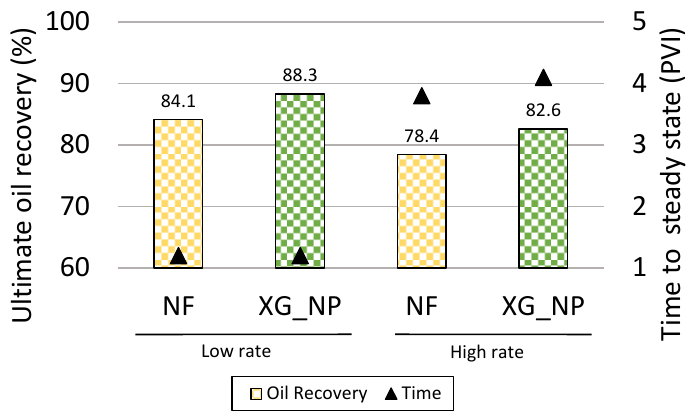
Figure 10. Ultimate oil recovery factor for the xanthan gum and NF at a low and high injections rate as a function of the time to reach the steady-state.